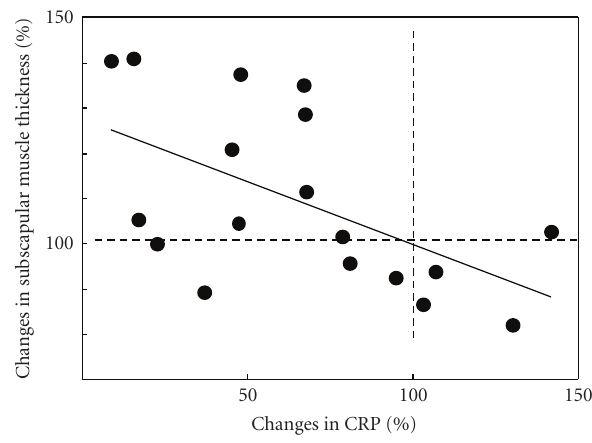
Figure 2: Correlation between percent change in CRP and subscapular muscle thickness r = − 0 . 61, P = . 008. Dotted lines (100%) represent the baseline value for each subject. A greater absolute increase would appear above 100%, and a greater absolute decrease would appear below 100%. Percentage change is calculated as [postvalues – prevalues]/[prevalues] ×